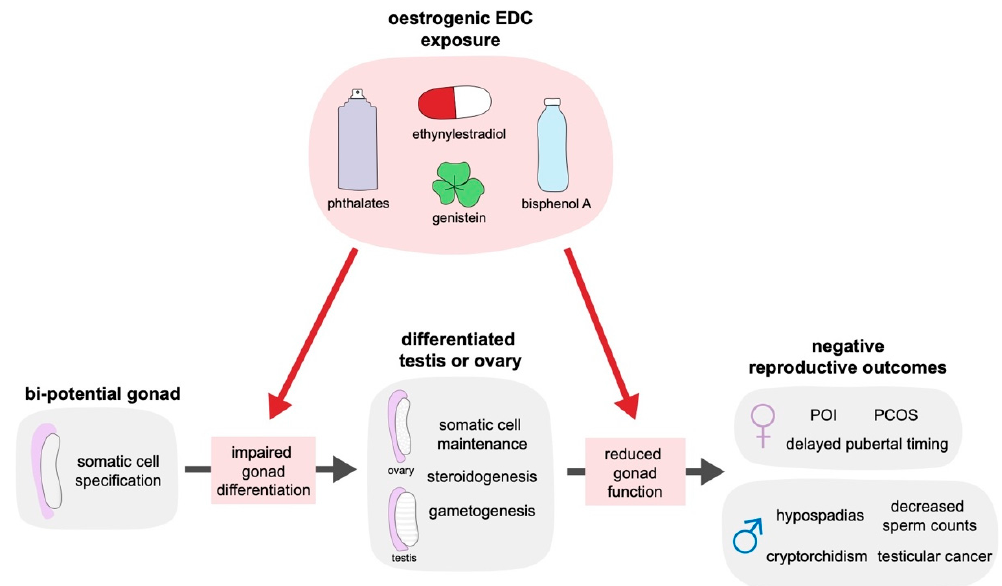
Figure 1. Exposure to oestrogenic endocrine disrupting chemicals, such as genistein (present in soy and subterranean clover), bisphenol A (a plasticiser), ethynylestradiol (a synthetic oestrogen present in the contraceptive pill), or phthalates (plasticisers, present in some cosmetics), can disrupt gonad development and function, leading to negative reproductive outcomes. Exposure of the bi-potential gonad as it undergoes differentiation into either an ovary or testis can disrupt somatic cell specification, an important step in establishing gonad fate. Exposure of the differentiated gonad can impact steroidogenesis, gametogenesis and the ongoing maintenance of somatic cell fate, disrupting the continuing function of the gonad. Either periods of exposure can contribute to the development of premature ovarian insufficiency (POI), polycystic ovary syndrome (PCOS), or cause delayed pubertal timing in females. In males, such exposures have been linked to testicular dysgenesis syndrome, comprising of hypospadias, cryptorchidism, decreased sperm counts, and testicular cancer.